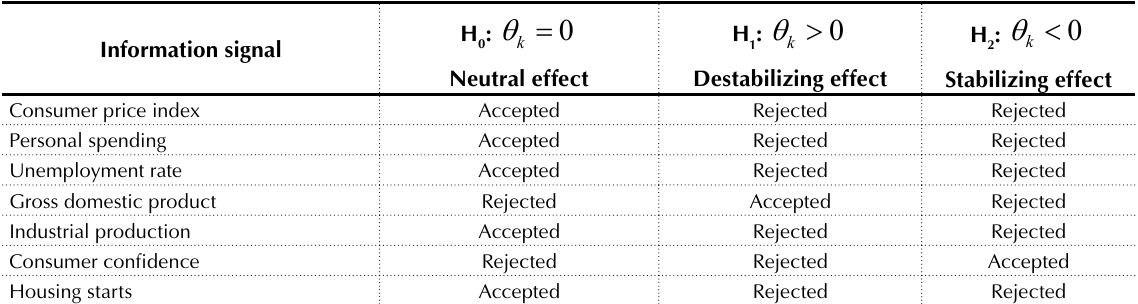
Table 14. The results of testing the hypotheses H component of the “surprise” of non-monetary information signals on stock quotes of enterprises of the economic sector